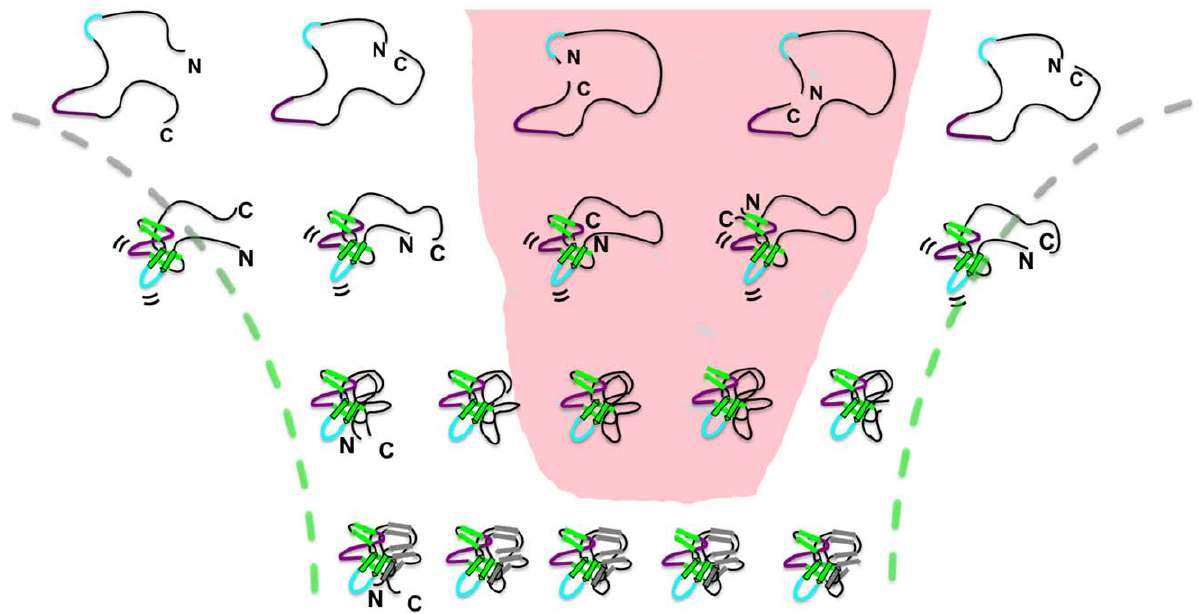
Figure 7. Multiple routes on the folding landscape of IL-1 b . Schematic depiction of the progression of folding for WT IL-1 b , (far left) PM23 (center left), PM65 (center), PM76 (center right), and PM142 (far right) proteins. The availability of multiple routes in IL-1 b is exploited by the functional driving force allowing for efficient packing of the functional loops (and the maintenance of function) at the expense of efficient folding, where even entropically less-favored routes (pink shaded area) are selected to ensure proper functional orientation. In the formation of the intermediate in WT, the central trefoil unit collapses bringing the functional loops (in purple and cyan) in the proper conformation and orientation. The intermediate is the same for all the permutants but the route to the intermediate from the unfolded state varies. In the case of the centrally cut permutants (PM65 and PM76), the proteins still fold, albeit through an entropically less favorable route, as the termini must coalesce first to generate the same functional intermediate. The energetic payoff of forming a functional intermediate outweighs the entropic cost of bringing the termini together.